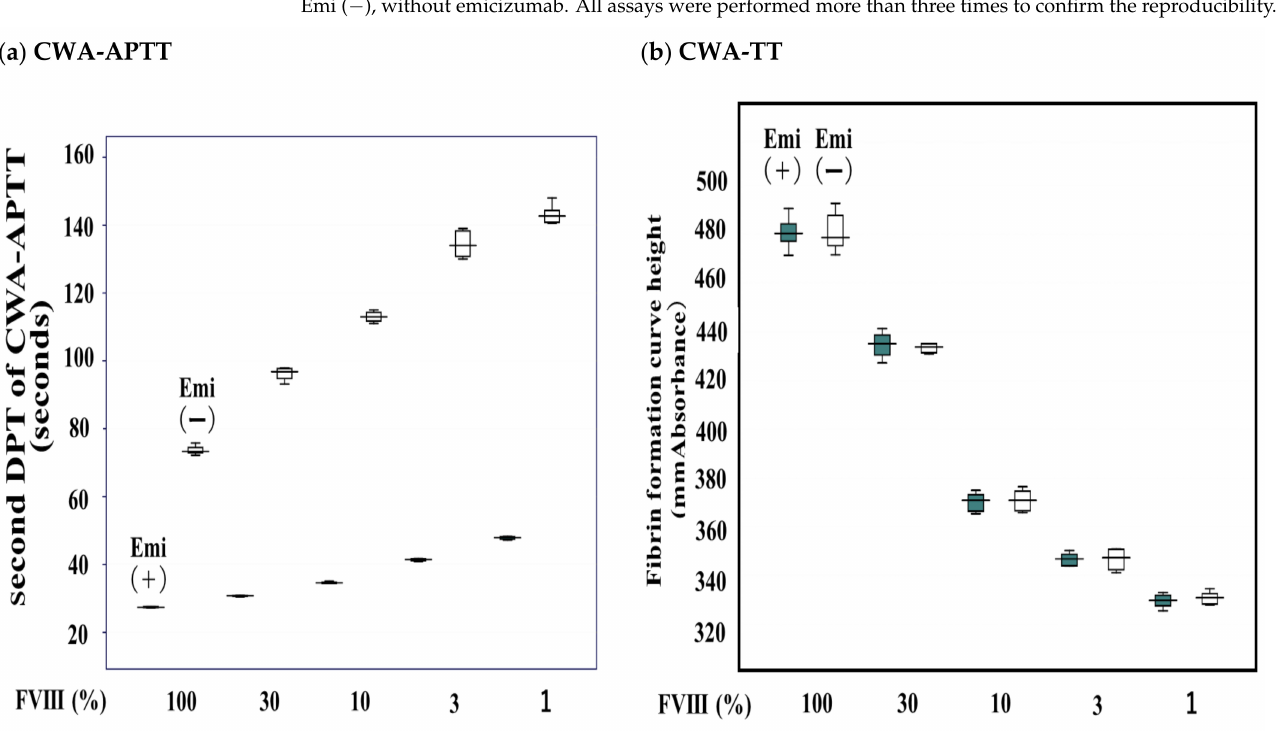
Figure 5. Standard curve of FVIII activity using the clot wave analysis (CWA) of activated partial thromboplastin time (APTT) ( a ) or thrombin time (TT) ( b ). Emi (+), with emicizumab; Emi ( − ), without emicizumab. All assays were performed more than three times to confirm the